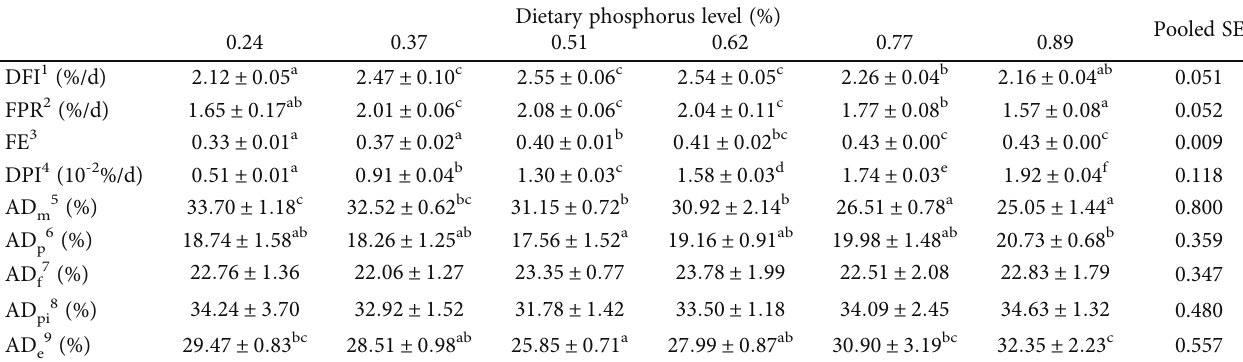
Table 3: Diet utilization of A. japonicus fed diets with di ff erent phosphorus levels. Dietary phosphorus level